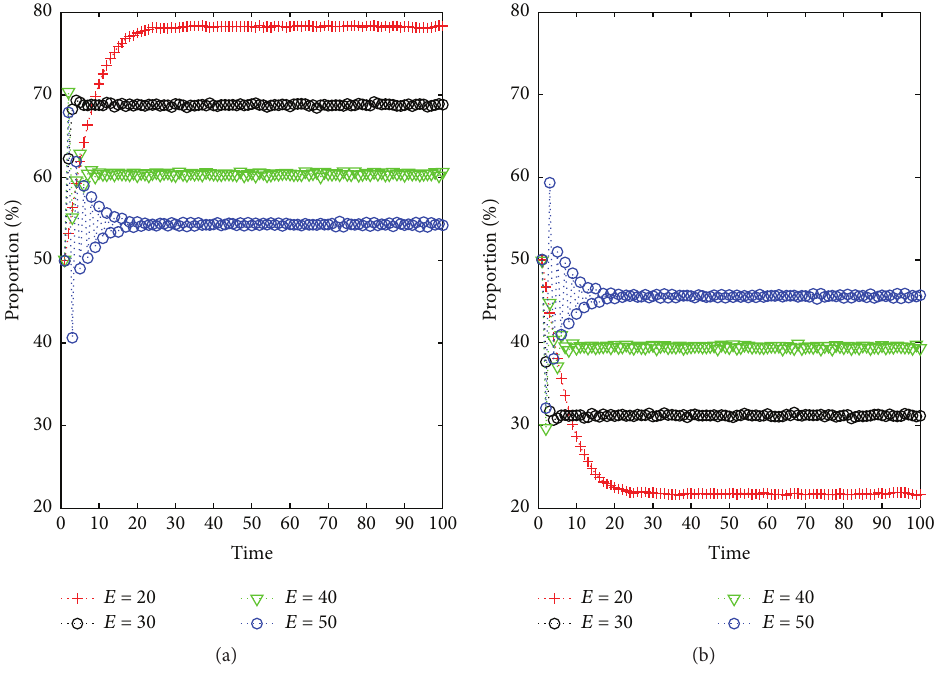
Figure 6: The proportion for (a) greedy and (b)